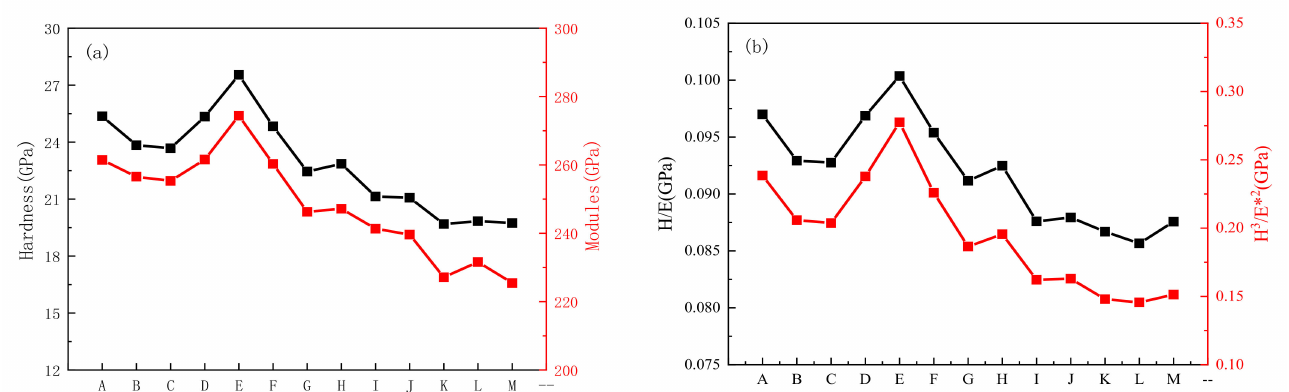
Figure 8. Room temperature mechanical properties of the (TiCrV)x-(TaW)1-x (A-M) binary system HEA films: ( a ) hardness (black-line segment) and modulus (red-line segment), ( b ) H/E (black-line segment) and H3/E*2 (red-line segment) calculation